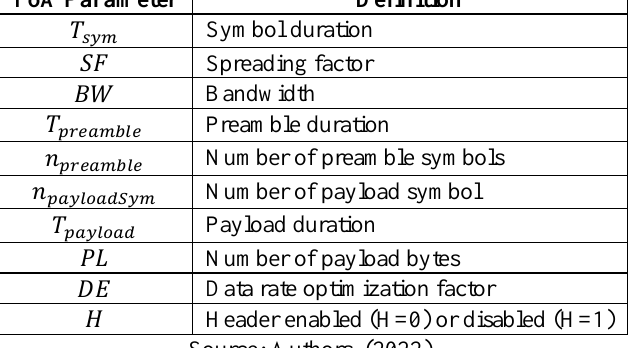
Table 3: Parameter definition for ToA Estimation.